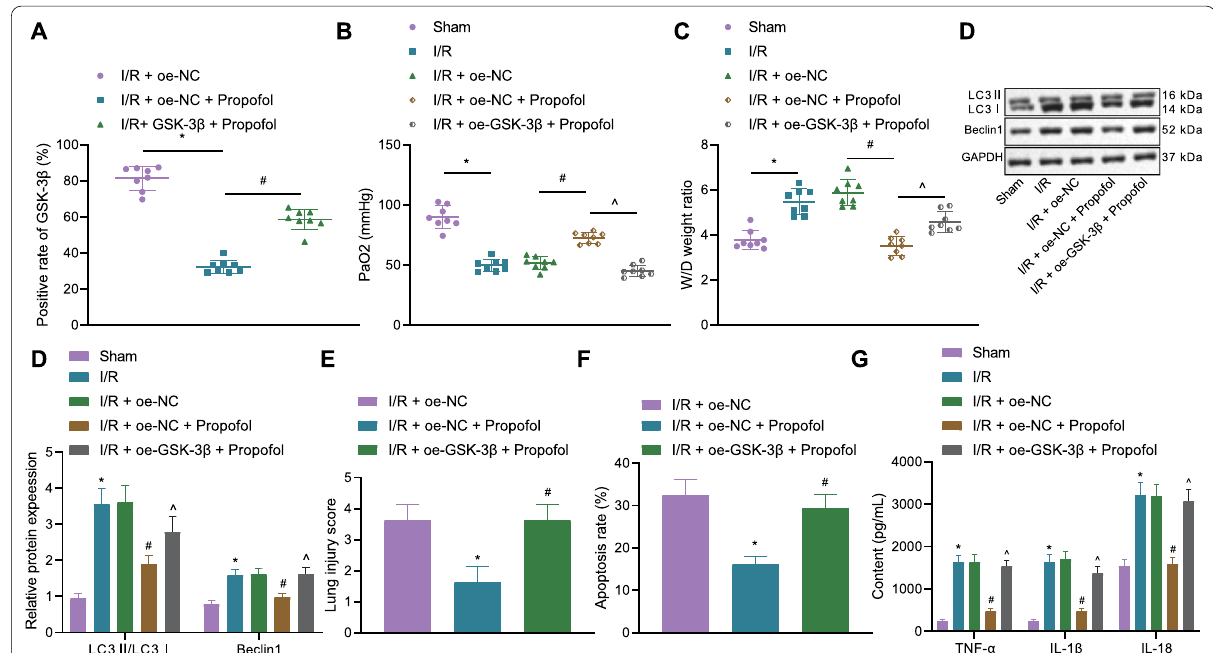
Fig. 4 Overexpressing GSK3β facilitates autophagy and inflammation in I/R mice. A Expression of GSK3β in lung tissues of mice as determined by immunohistochemistry (8 mice in each group; * p < 0.05, compared with the I/R oe‑NC group; # p < 0.05, compared with the I/R oe‑NC Propofol + + + group). B PaO 2 level of mice (8 mice in each group; * p < 0.05, compared with the sham group; # p < 0.05, compared with the I/R oe‑NC group; + $ p < 0.05, compared with the I/R oe‑NC Propofol group). C W/D ratio of mice (8 mice in each group; * p < 0.05, compared with the sham group; + + # p < 0.05, compared with the I/R oe‑NC group; $ p < 0.05, compared with the I/R oe‑NC Propofol group). D The expressions of GSK3β and + + + autophagy‑related protein levels in lung tissues as detected by Western blot analysis (8 mice in each group; * p < 0.05, compared with that of the sham group; # p < 0.05, compared with the I/R oe‑NC group; $ p < 0.05, compared with the I/R oe‑NC Propofol group). E Pathological changes + + + of lung tissues of mice as detected by H&E staining (8 mice each group; * p < 0.05, compared with that of the I/R oe‑NC group; # p < 0.05, compared + with the I/R oe‑NC Propofol group). F Cell apoptosis in lung tissues as determined by TUNEL staining (8 mice each group; * p < 0.05, compared + + with that of the I/R oe‑NC group; # p < 0.05, compared with the I/R oe‑NC Propofol group). G Levels of TNF‑α, IL‑1β, and IL‑18 in supernatant + + + of lung tissues of mice as measured by ELISA (8 mice in each group; * p < 0.05, compared with the sham group; # p < 0.05, compared with the I/R oe‑NC group; $ p < 0.05, compared with the I/R oe‑NC Propofol group). The experiment was repeated 3 times + + +